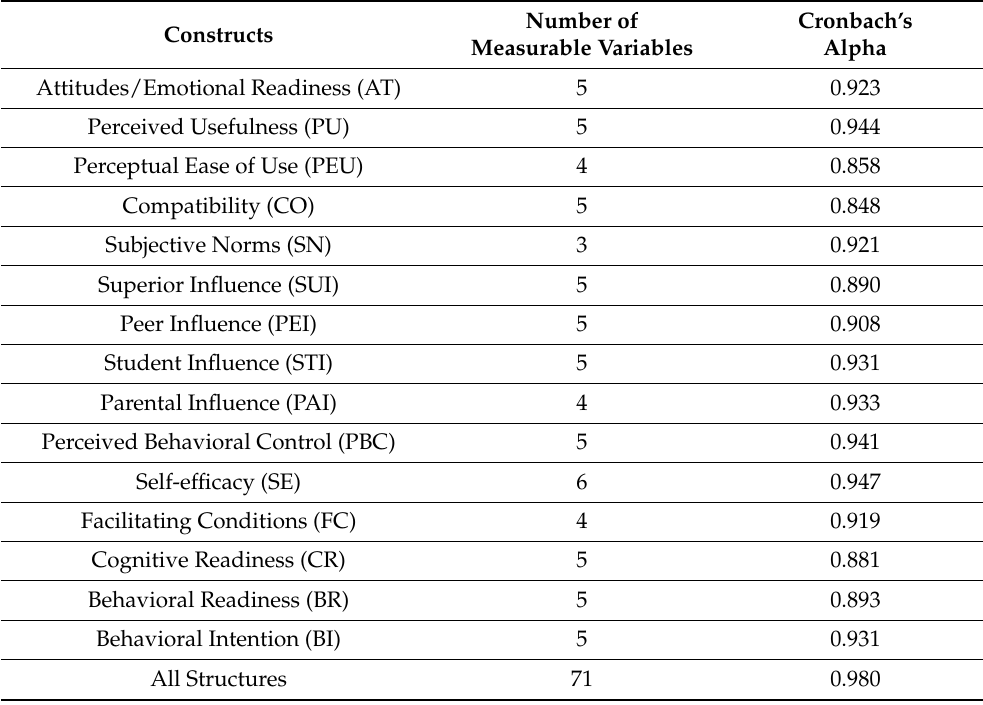
Table 1. Reliability